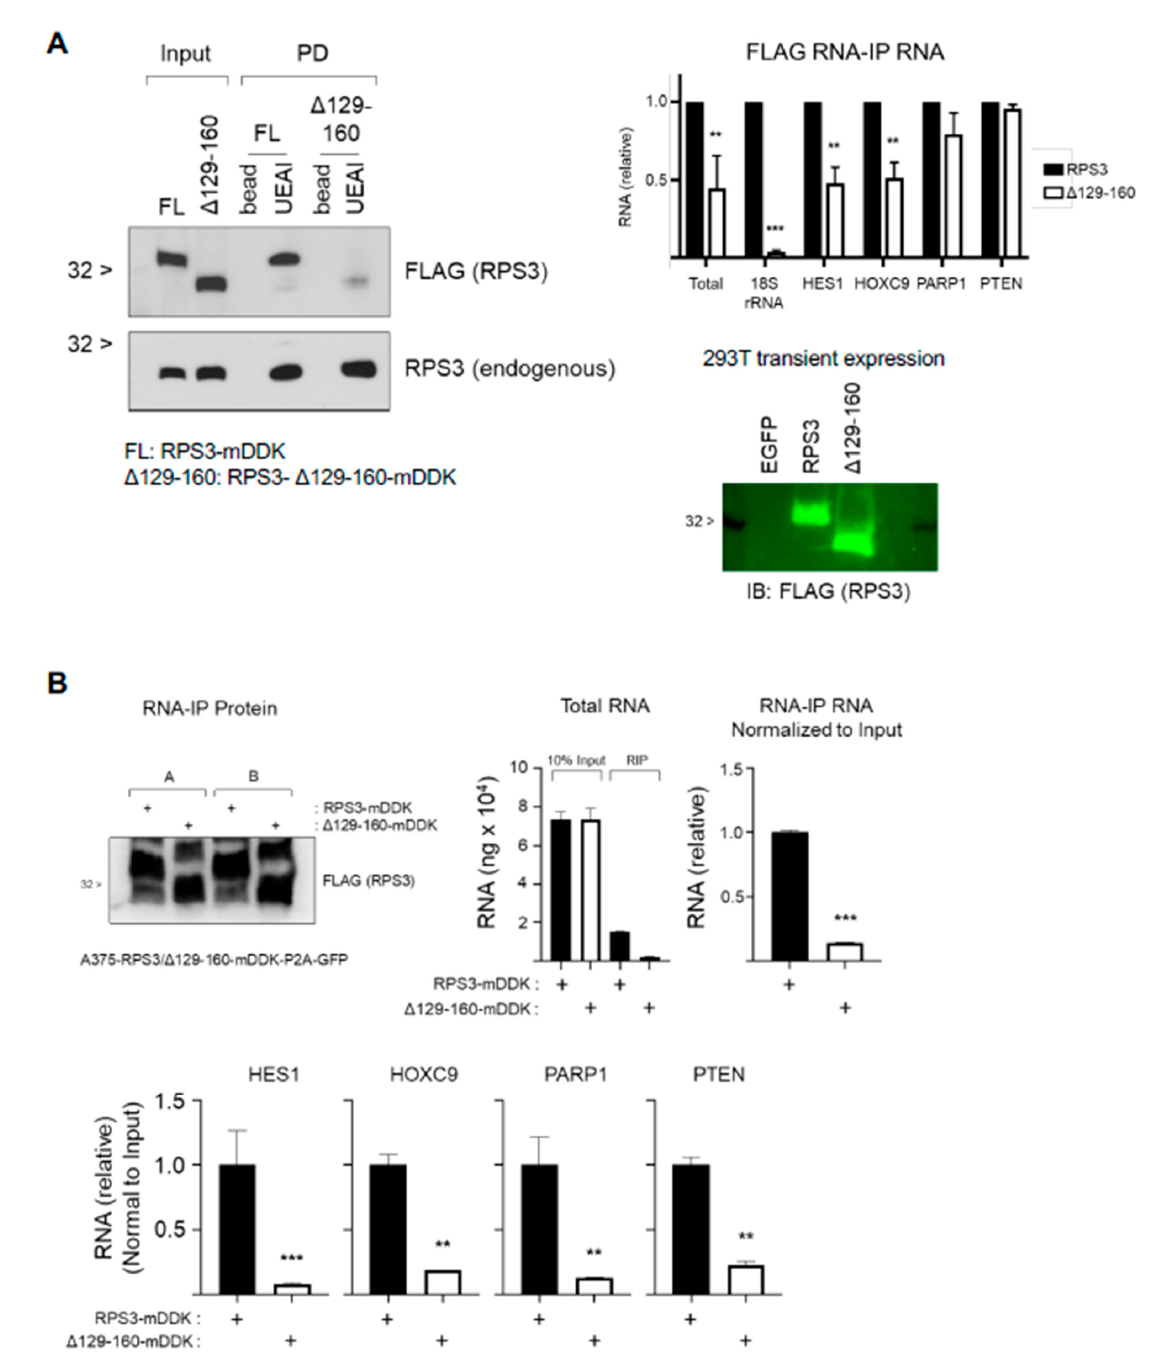
Figure 6. RPS3 fucosylation mutant shows impaired ability to interact with RNA. ( A ) Fucosylation mutant RPS3 missing amino acids 129—160 (RPS3- Δ 129-160-mDDK) was transfected into 293T for 2 d prior to harvest for protein lysate. Lysates were subsequently analyzed for RPS3 fucosylation by UEAI-PD and Western blot. Membranes were probed for FLAG to detect the deletion mutant and for RPS3 to detect endogenous RPS3. The ability of the mutant to interact with RNA was tested by FLAG RIP and subsequent RNA purification and analysis by qPCR. A sample from FLAG RIP was taken for protein analysis to confirm equal amount of RPS3 was immunoprecipitated. Results were analyzed by 2-way ANOVA ( n = 2). ( B ) A375 cells expressing either RPS3-mDDK- or RPS3- Δ 129-160-mDDK-P2A-GFP were sorted on GFP+ cells, grown back up and immediately harvested for FLAG RIP analysis. A sample from FLAG RIP was taken for protein analysis to confirm equal amount of RPS3 was immunoprecipitated. Results were analyzed by 2-way ANOVA ( n = 2). ** p < 0.01; *** p <